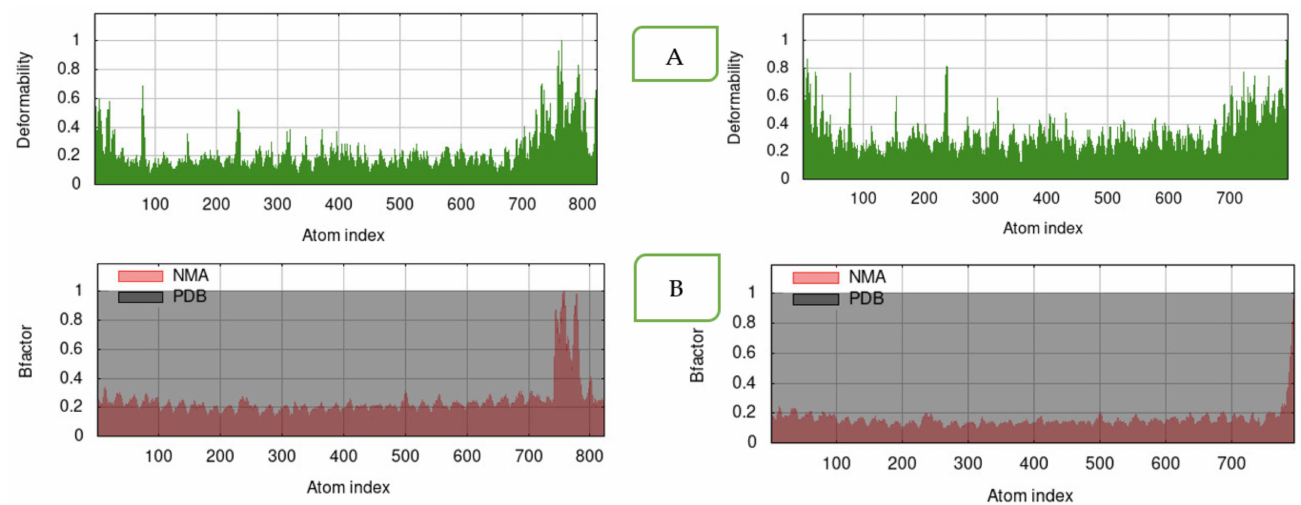
Figure 5. The results of molecular dynamics simulation of VT1 (left) and VT2 (right) constructs, and TLR-9 docked complex. ( A ) deformability; ( B ) variance (red color indicates individual variances and green color indicates cumulative variances)